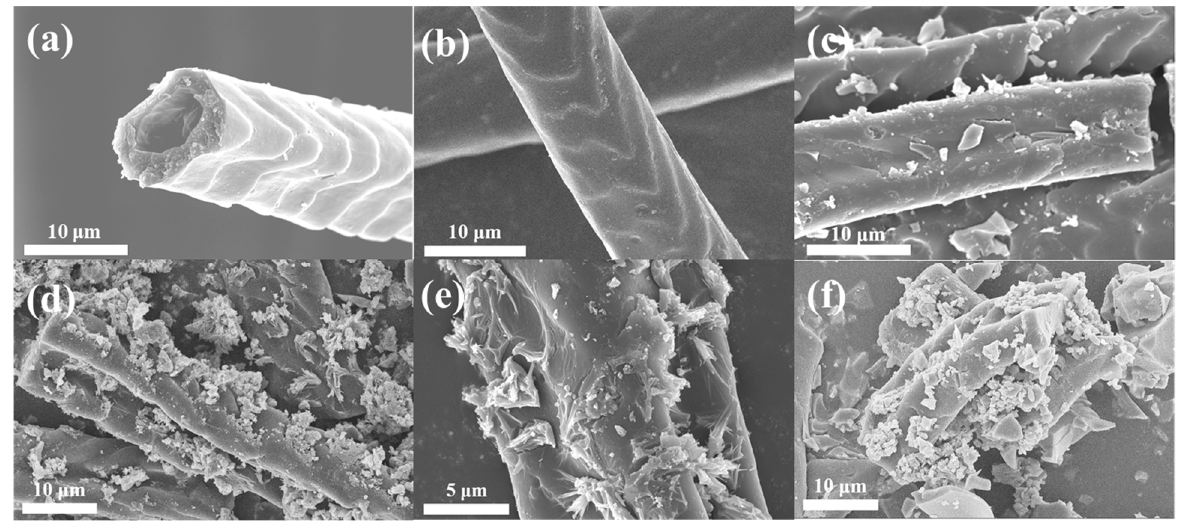
Figure 3. SEM images of ( a ) rabbit hair fiber, ( b ) carbonized rabbit hair fiber, ( c ) TiO 2 /CRFs = 3:1, ( d ) TiO 2 /CRFs = 5:1, ( e ) TiO 2 /CRFs = 5:1 (partial enlarged detail) and ( f ) TiO 2 /CRFs = 7:1.